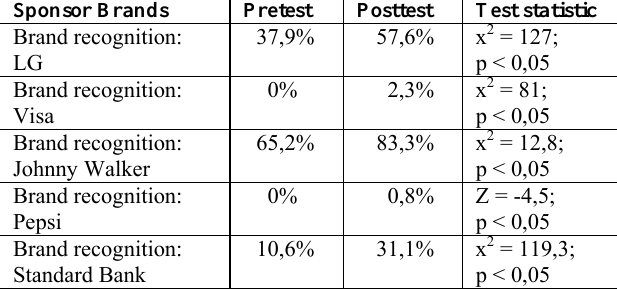
Table 2: Brand recognition: sponsor